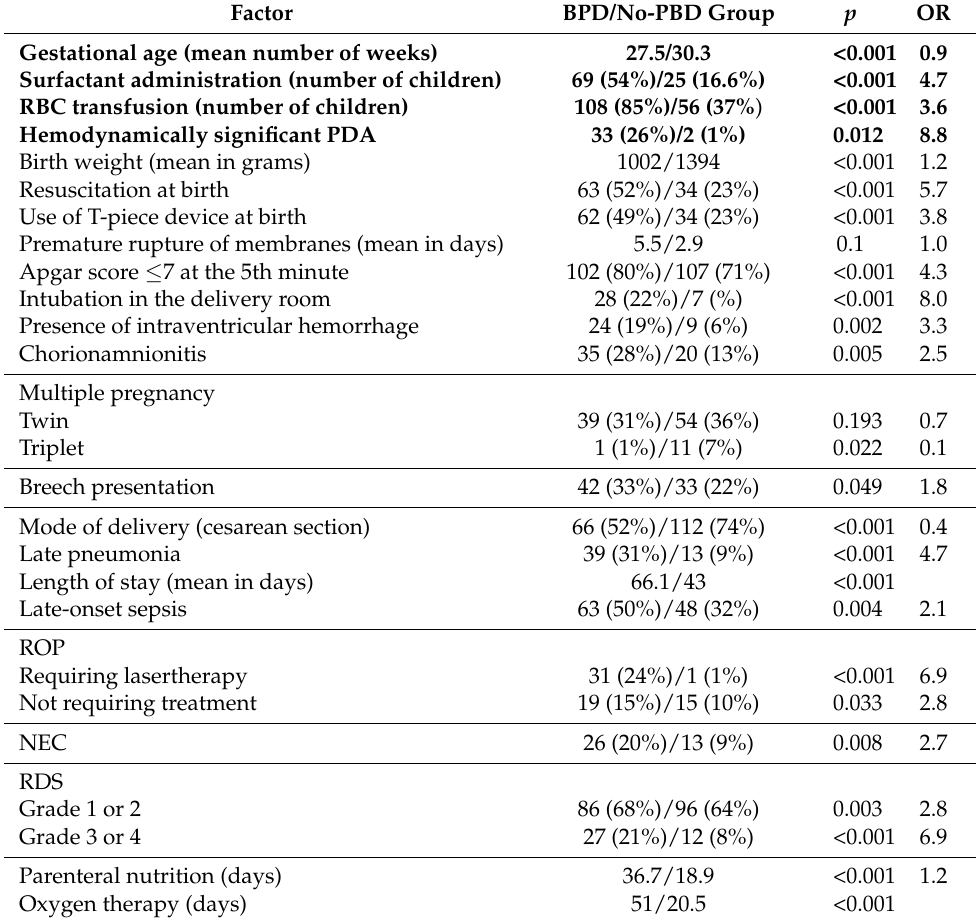
Table 2. Risk factors for bronchopulmonary dysplasia in univariate